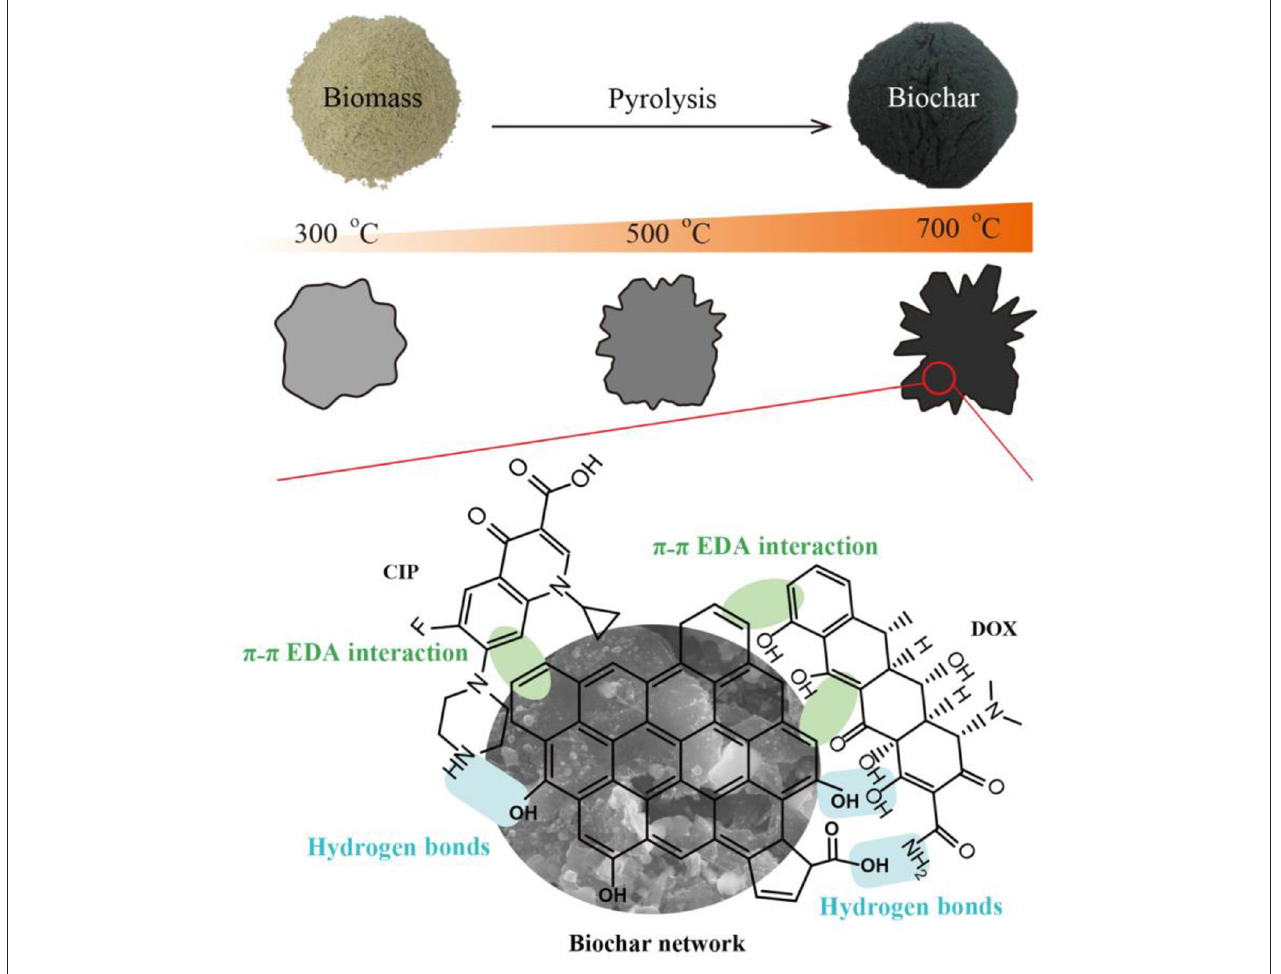
FIGURE 6 | The proposed mechanisms for DOX and CIP